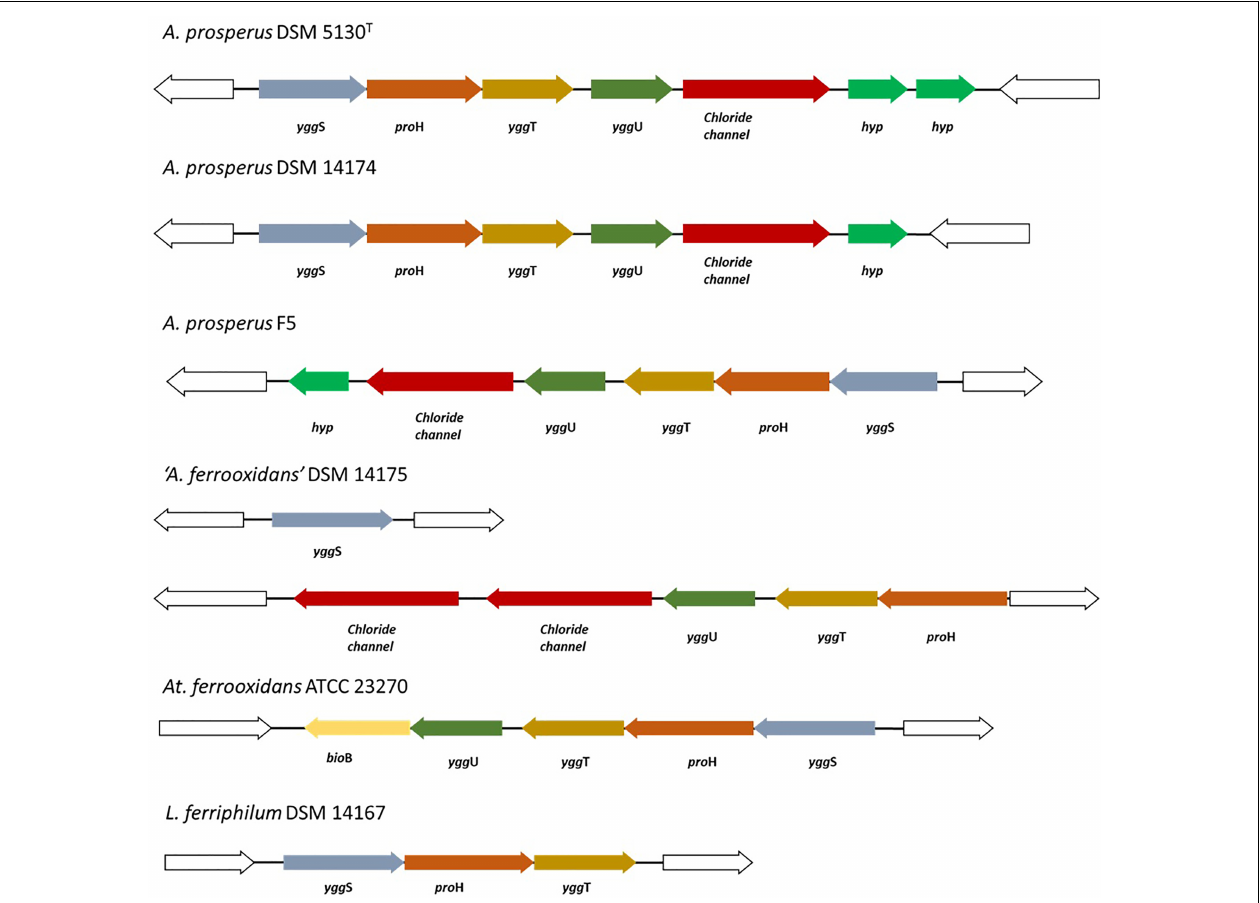
FIGURE 6 | Comparison of the yggS - proH - yggT - yggU operon in members of the Acidihalobacter genus against that in salt sensitive, acidophilic A. ferrooxidans ATCC 23270 and the moderately salt tolerant L. ferriphilum DSM 14167. The members of the Acidihalobacter genus all encoded chloride ion channel proteins in the